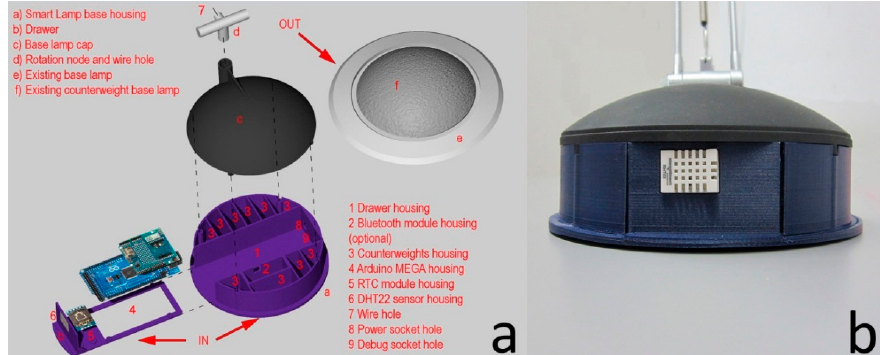
Figure 3. Smart Lamp: ( a ) assembly diagram of the base; ( b ) as installed.